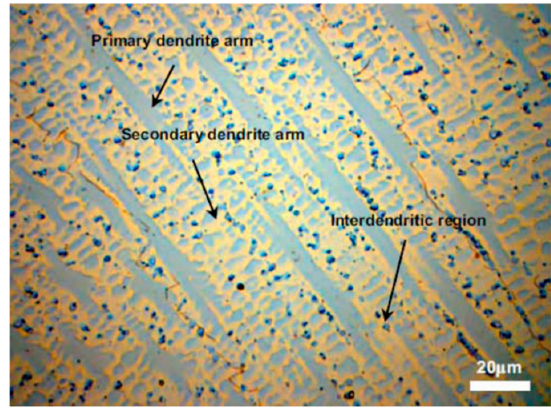
Figure 13. Primary weld metal microstructure with Inconel 625 filler wire.